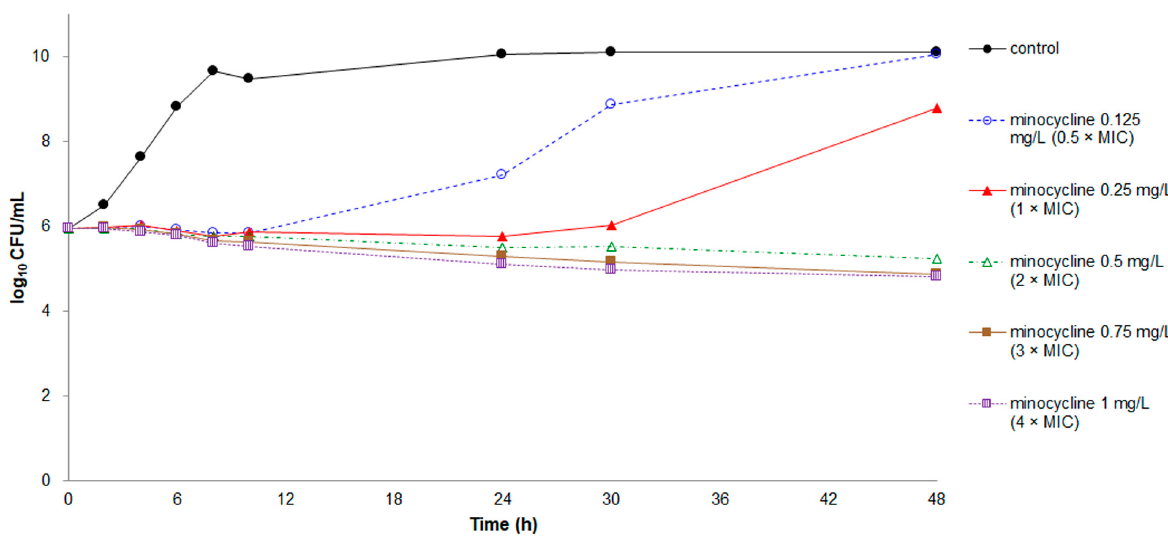
Figure 1. Time-kill assays for minocycline against Elizabethkingia anophelis strain ED853-49. Data points represent the mean of three experiments. Minimum inhibitory concentration (MIC) of minocycline = 0.25 mg/L.